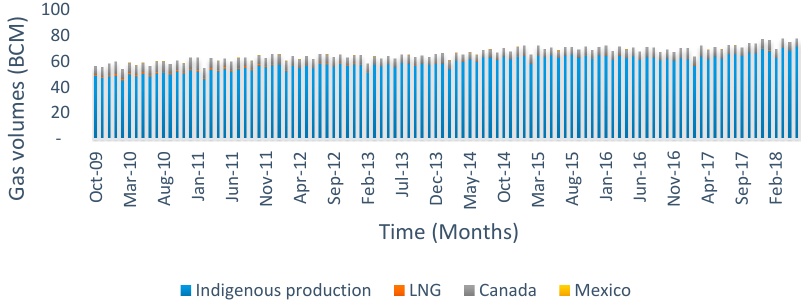
Figure 1. Indigenous production and monthly gas imports to U.S. Source: EIA (Available on EIA website, https://www.eia.gov/naturalgas/monthly/).